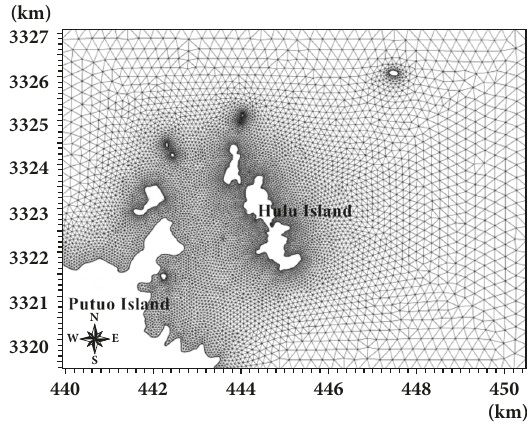
Figure 7: Grids generation of tidal model.